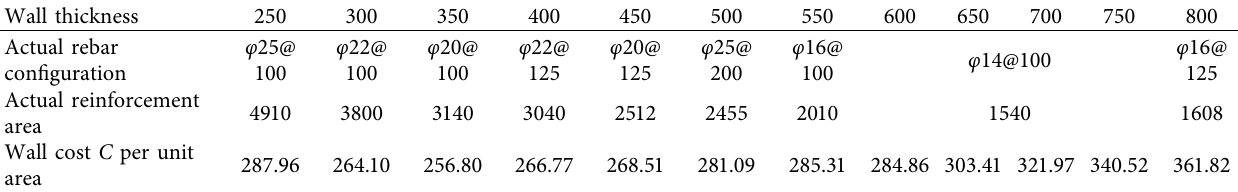
Table 6: Wall costs per unit area of pool walls with optimal rebar configuration